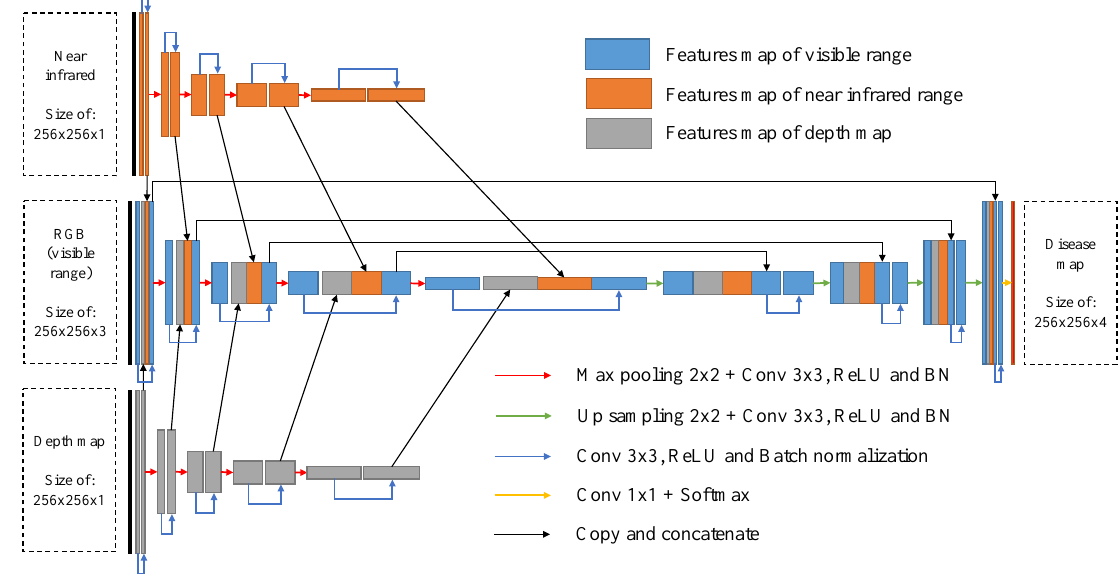
Figure 3. VddNet